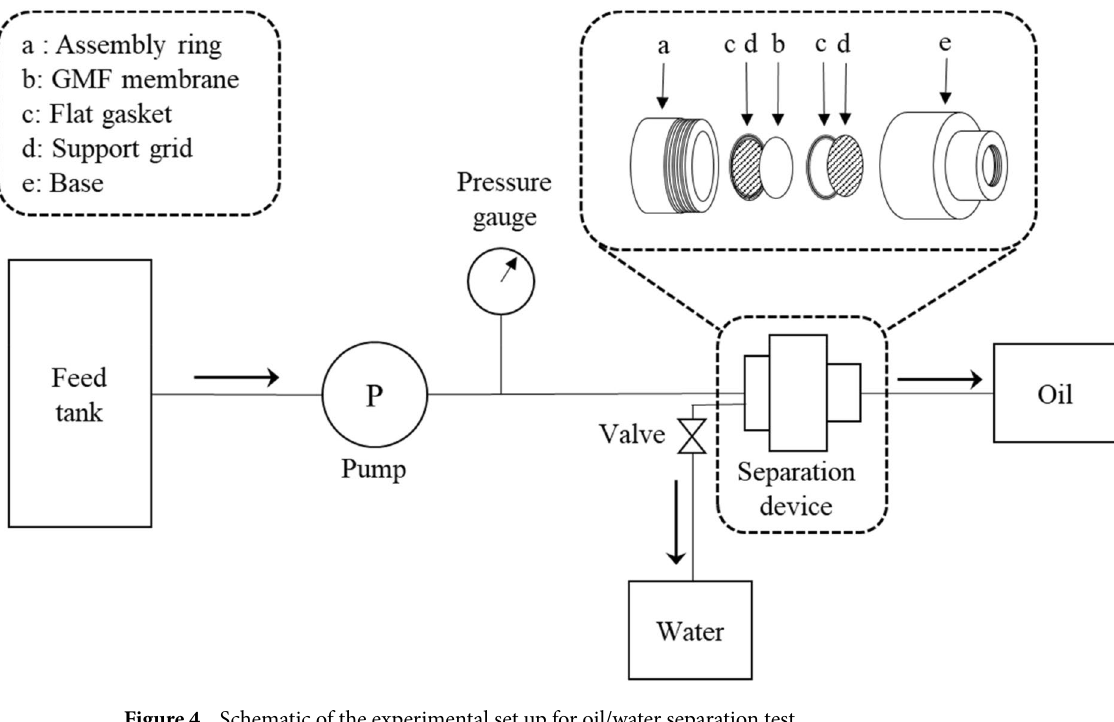
Figure 4. Schematic of the experimental set up for oil/water separation test.